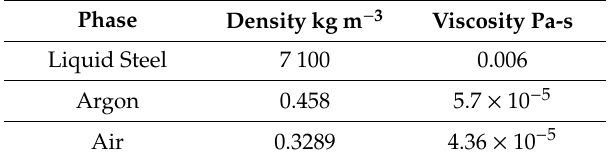
Table 2. Physical properties of the phases in the tapping operations